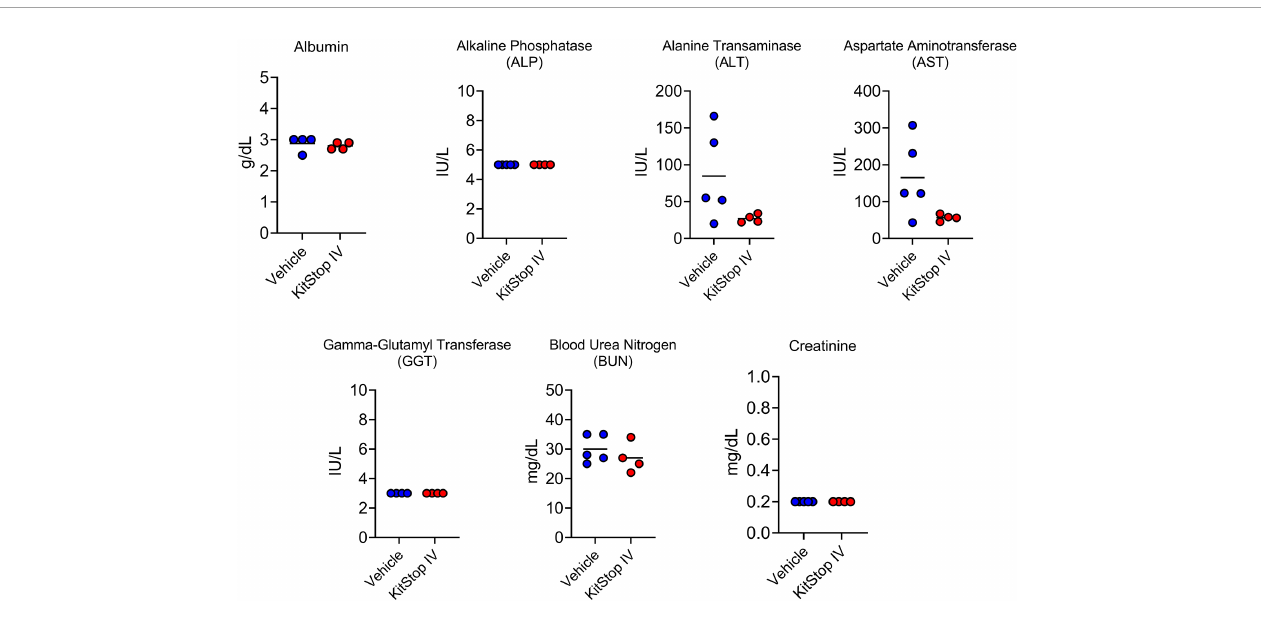
FIGURE 6 Intravenous KitStop ESO administration does not cause organ dysfunction. Serum biochemical parameters for liver and kidney function measured from whole blood isolated from Balb/c mice with cardiac puncture after 21 days of either PBS vehicle control (blue) or KitStop ESO (red) treatment administered every 3 days. No signi fi cant differences were observed between the groups.